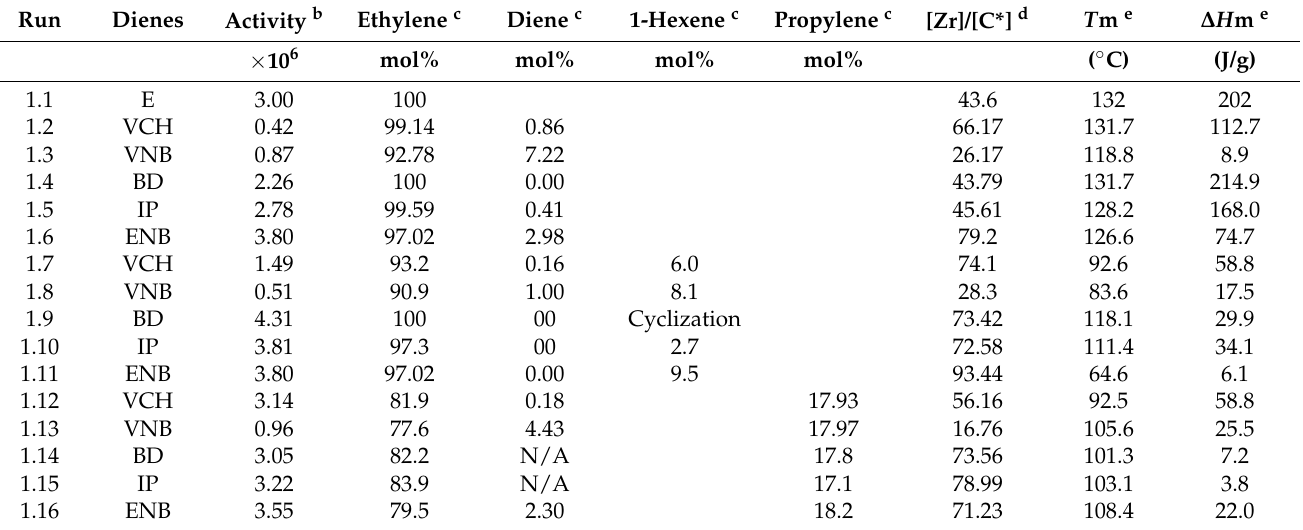
Table 1. E/diene, E/diene/1-hexene and E/diene/propylene polymerization catalyzed with ( rec